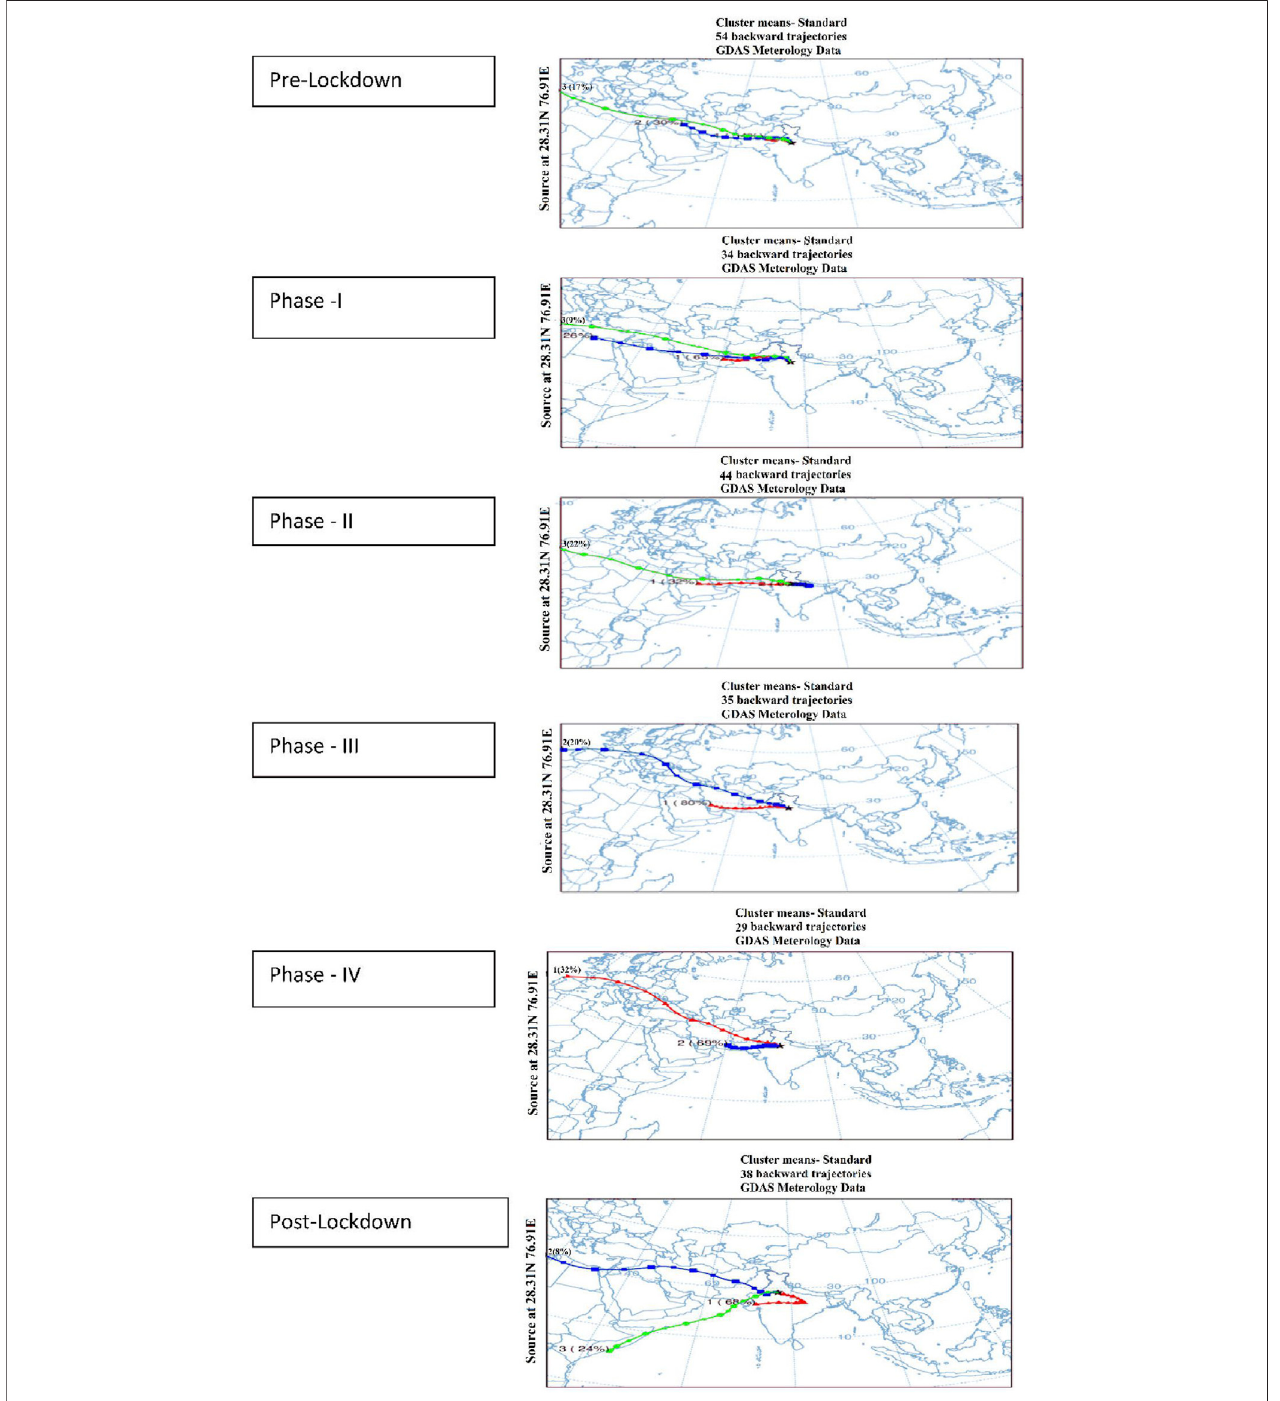
FIGURE7| Airmassbackwardtrajectory(Sourceat28.37N,76.91E)clusterfortheBCdataofpre-,I,II,III,IV,andpost-lockdownphasesduring1March – 30June 2020.